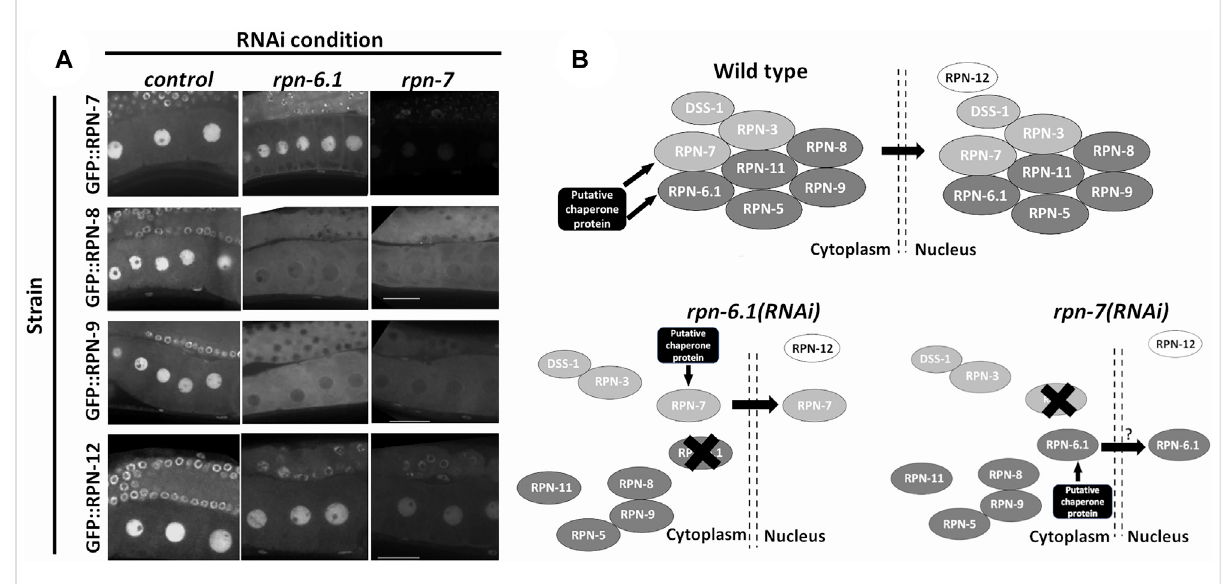
FIGURE 8 RPN-6.1 and RPN-7 are required for the nuclear localization of RPN-8 and RPN-9. (A) Live imaging of hermaphrodite oocytes from endogenously GFP tagged strains rpn-7[ana1(gfp::rpn7)] , rpn-8[ana4(gfp::rpn-8)] , rpn-9[ana5(gfp::rpn-9)] and rpn-12[ana6(gfp::rpn-12)] treated with either control(RNAi), rpn-6.1(RNAi) or rpn-7(RNAi) ( n = 15 – 42). Scale bar represents 25 µm. (B) Model for role of RPN-6.1 and RPN-7 in nuclear localization of 19S RP lid combining existing information on eukaryotic proteasome assembly model (Budenholzer et al., 2017; Bai et al., 2019).